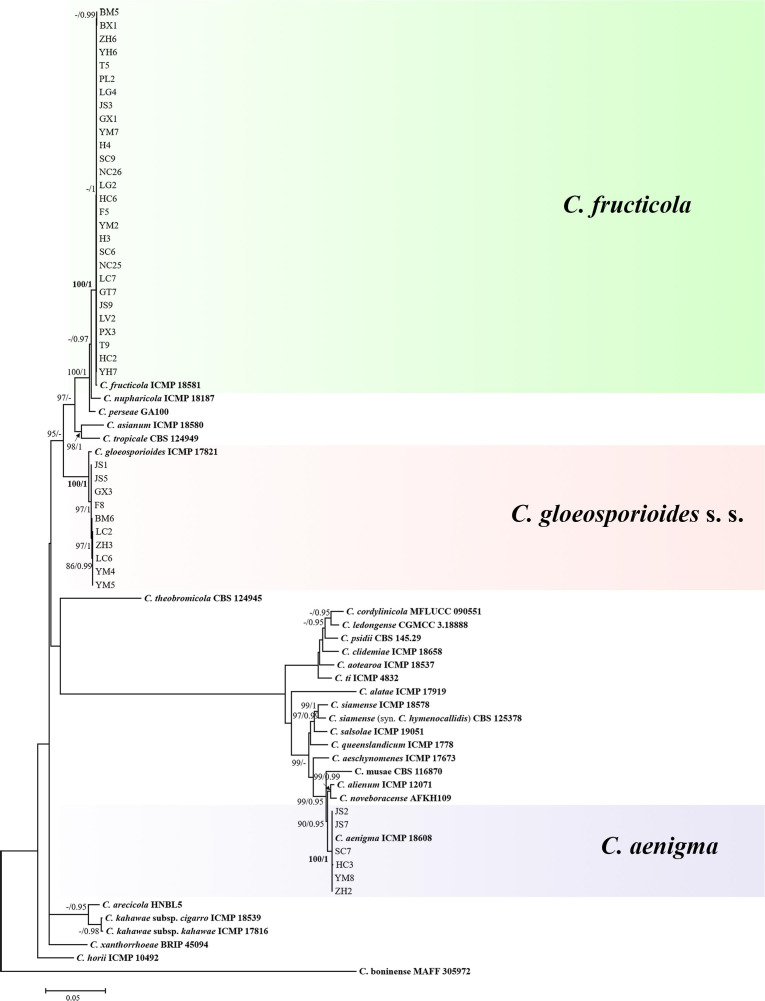
Maximum-likelihood phylogenetic tree of 66 isolates of the Colletotrichum gloeosporioides species complex. The tree was built using concatenated sequences of the ITS, GAPDH, CAL, ACT, CHS-1, TUB, GS, and ApMat region or genes, each with a separate model of DNA evolution. The tree generated by Bayesian inference had a similar topology. Bootstrap support values above 85% and Bayesian posterior probability values above 0.95 are shown at the nodes. Ex-type or other authoritative cultures are emphasized in bold font. C. boninense (MAFF 305972) was used as an outgroup. The scale bar indicates the average number of substitutions per site.